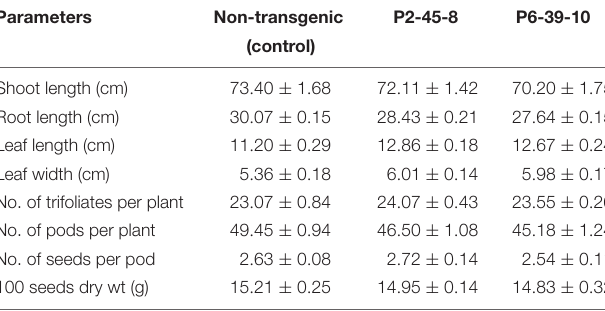
TABLE 3 | Morphological and yield contributing characters of T 2 transgenic plants raised in